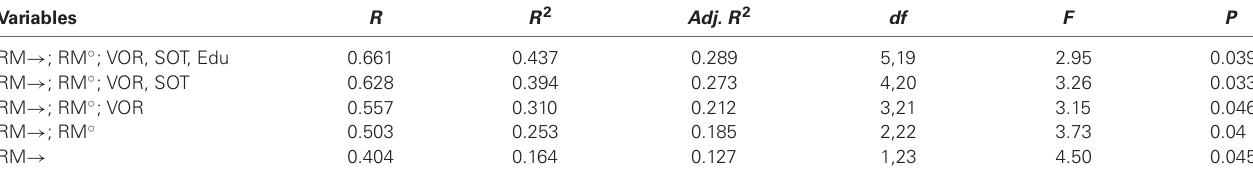
Table 2B | Regression analysis for the Virtual Pond Maze . Variables R R